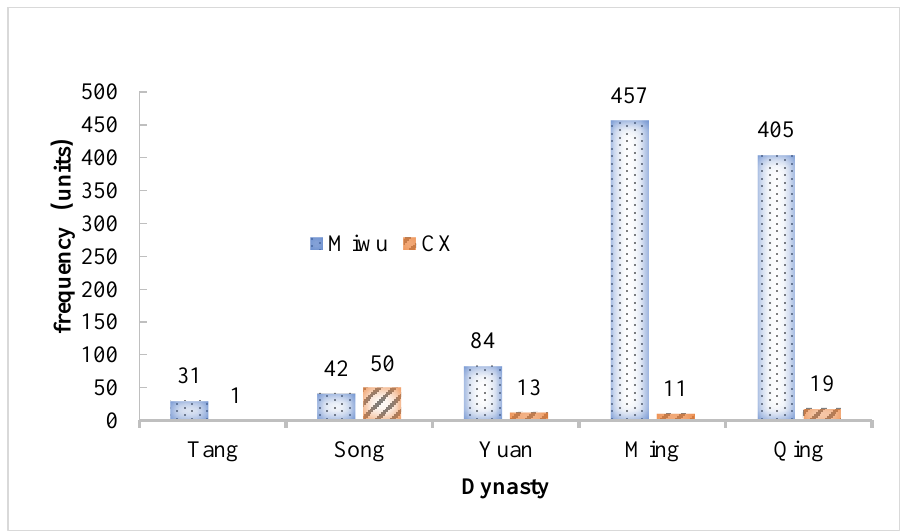
Figure 2. The frequency of Miwu and CX in ancient Chinese classical literature. Tang 618 – 907 AD, Song 960 – 1279 AD, Yuan 1271 – 1368 AD, Ming 1368 – 1683 AD, and Qing 1683 – 1840 AD.